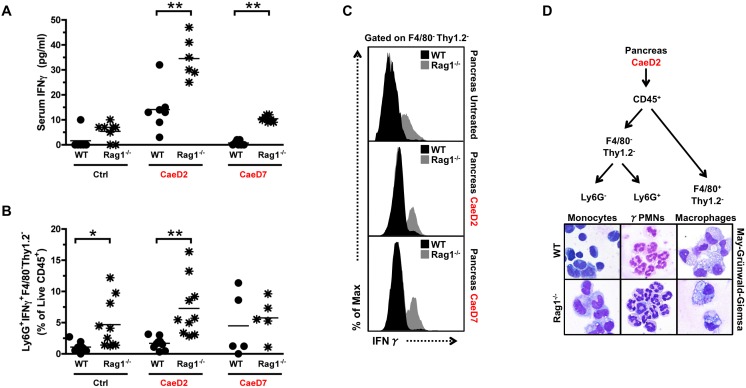
γPMNs are present during caerulein-induced injury in WT mice and are elevated in Rag1−/− mice.(A) IFNγ levels in serum isolated from WT and Rag1−/− mice with and without caerulein treatment (n = 6–8, *P<0.05, **P≤0.01, t test). (B) FACS analysis of the percentage of F4/80−Thy1.2− cells expressing Ly6G+ and IFNγ+ in the pancreas of WT and Rag1−/− mice with or without caerulein treatment (n = 5–8, *P<0.05, **P<0.01, t test). (C) Percentage of Ly6G+IFNγ+ (CD45+F4/80−Thy1.2−) amongst live CD45+ cells infiltrating the pancreas with or without caerulein treatment as indicated. (D) Sort strategy isolating indicated populations from the pancreas of WT and Rag1−/− mice and cytospin preparation visualizing May-Grünwald-Giemsa staining.